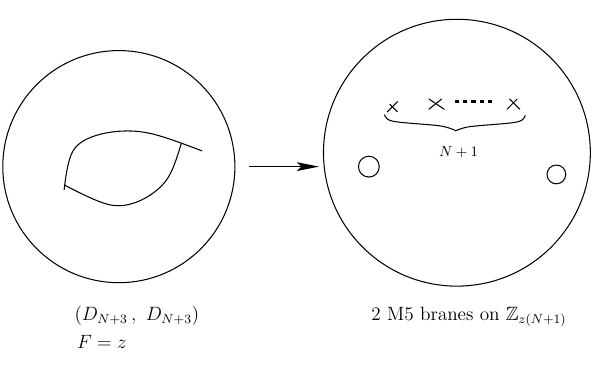
Figure 13. The relation between one M5 brane on D and two M5 branes on A types of